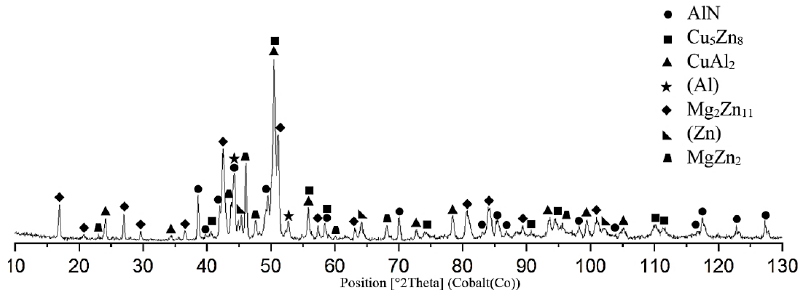
Figure 23. The XRD analysis of the fractured surface of AlN/Zn5Al3Mg/Cu joint.